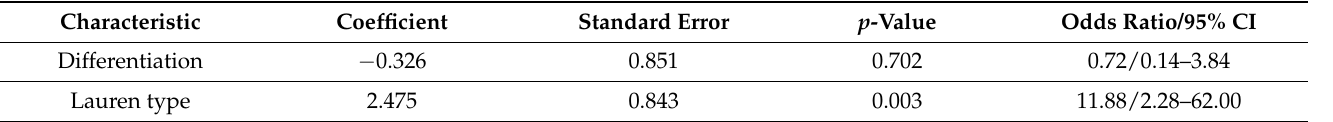
Table 6. Identification of independent feature for LGALS9 gene expression—multiple logistic